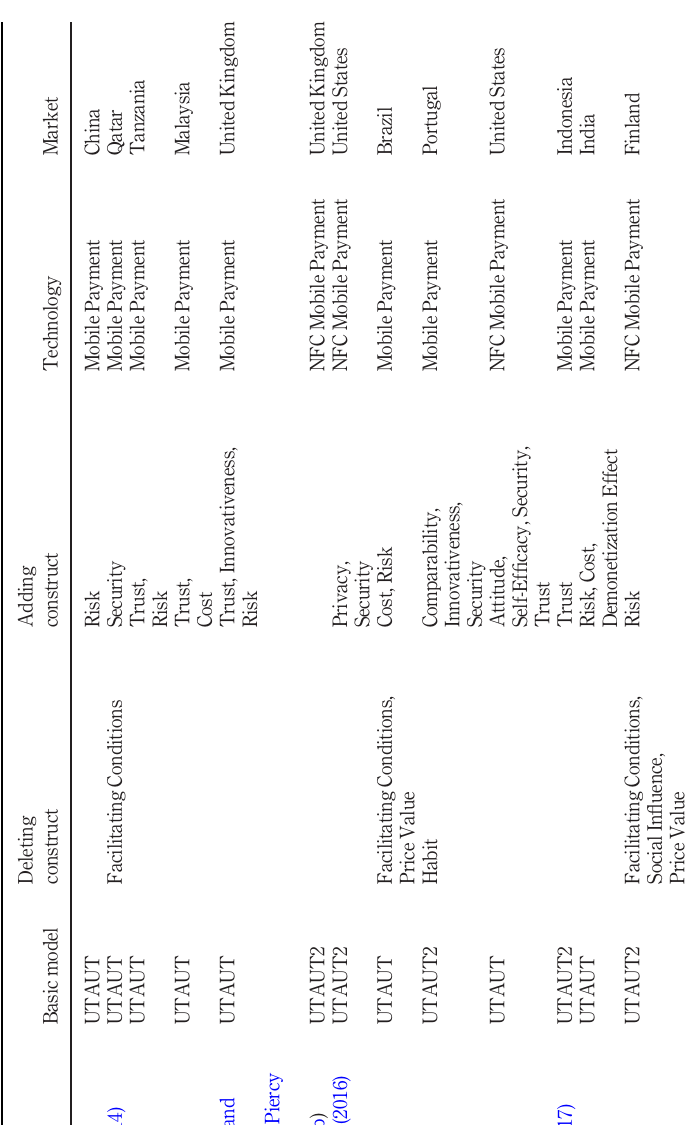
Table 2. Mobile payment studies using the UTAUT